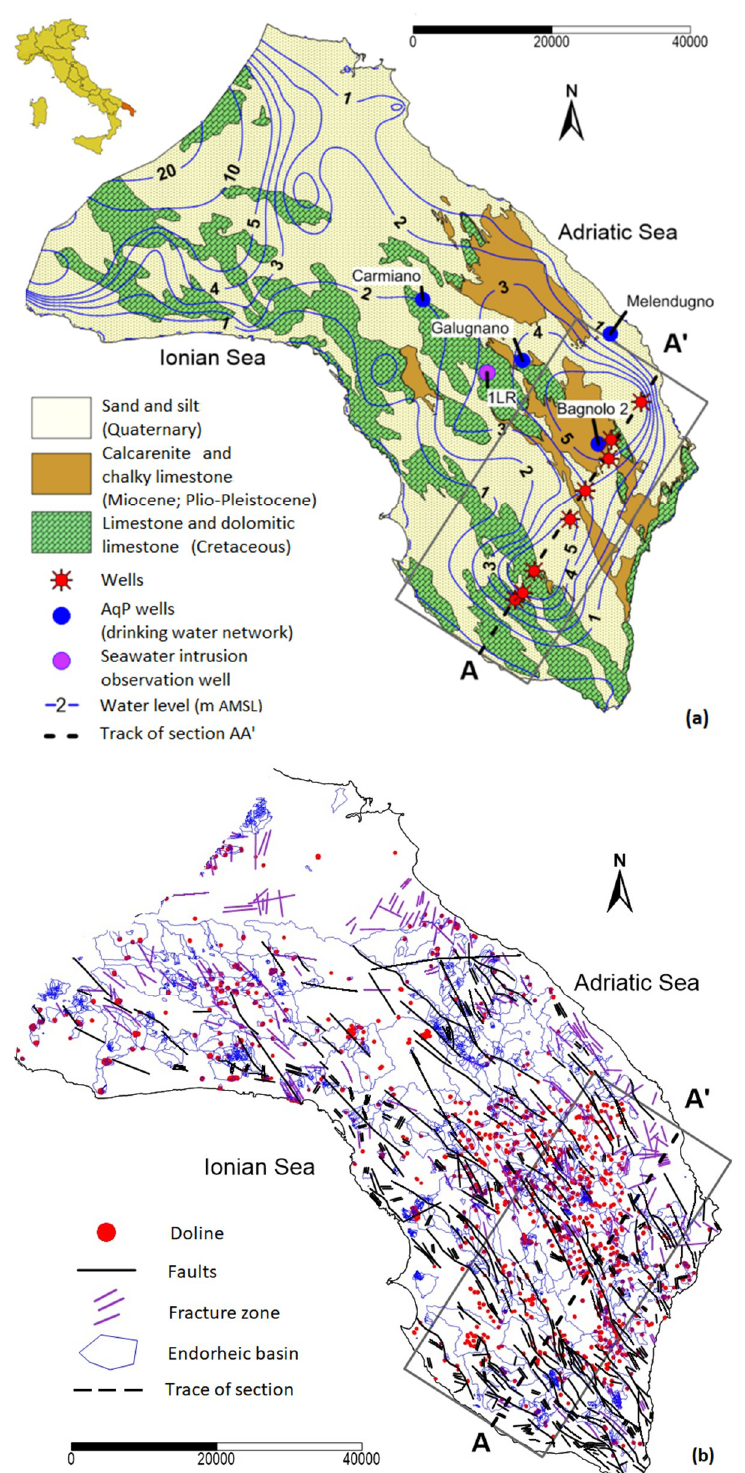
Figure 3. Salento Peninsula—( a ) geo-lithological map, water level contours of the karst coastal aquifer (m AMSL), track of the section AA’ (shown in Figure 4) with considered wells; position of the observation well Red Lake (LR) and Acquedotto Pugliese (AqP) wells; ( b ) distribution of endorheic basins, dolines, main faults and fracture zones, and track of the section AA’.